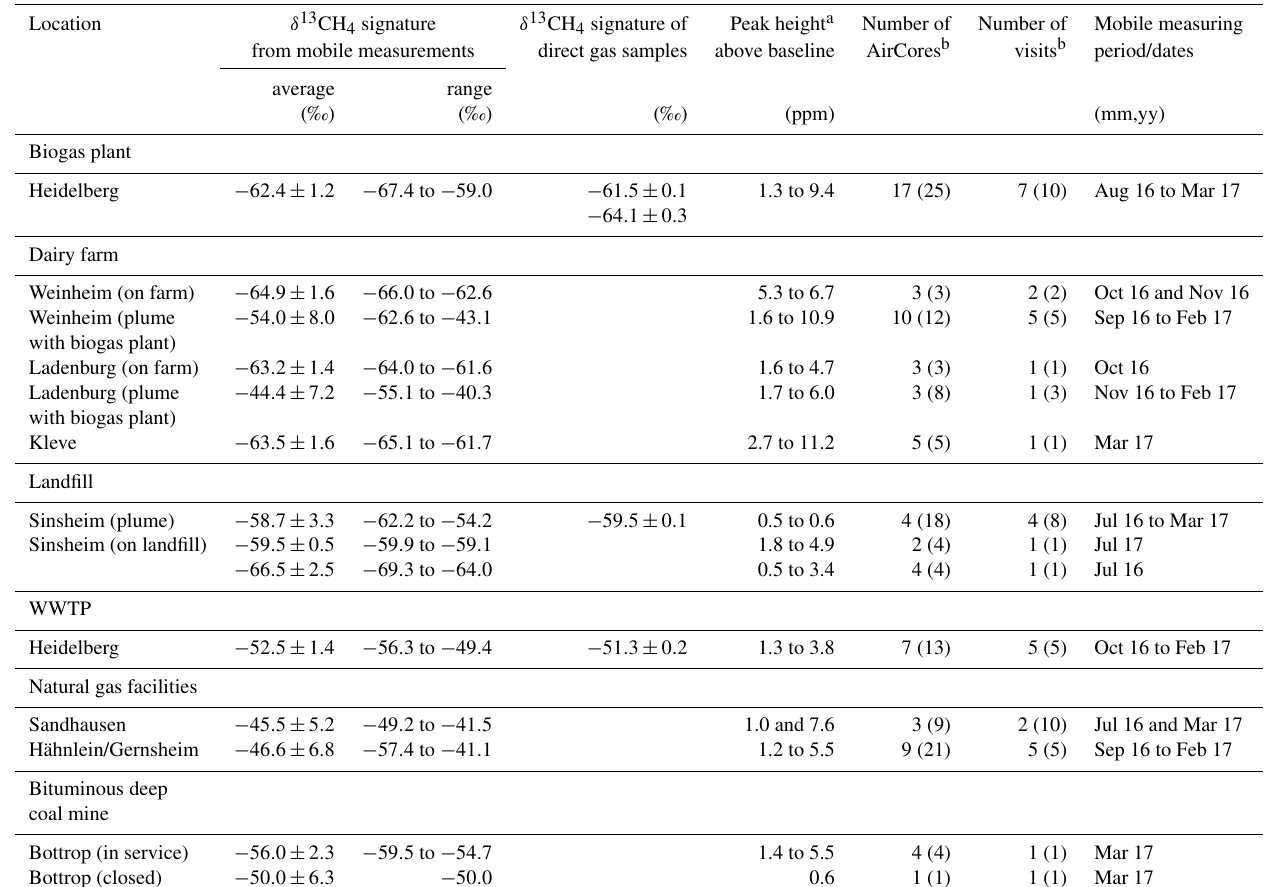
Table 2. Determined δ 13 CH 4 signatures of CH 4 sources.